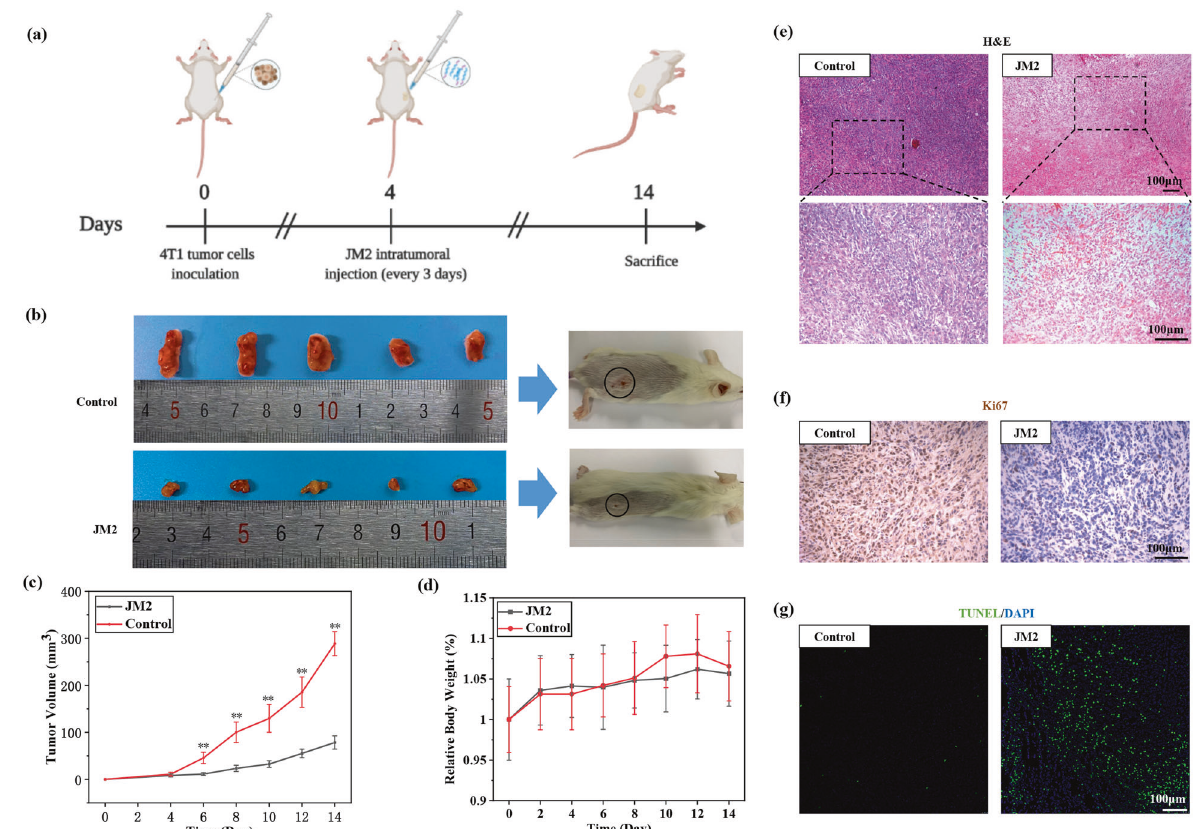
Fig. 1 JM2 inhibited tumor growth in vivo. a Schematic illustration of the in vivo anti-tumor experimental protocol. b Representative images of tumors in Control and JM2 groups at day 14. c Tumor volume at each time interval measured during treatment. d Body weight curve of mice monitored during treatment. e H&E staining of tumors obtained from Control and JM2 groups at day 14. f Ki67 immunohistochemical staining (brown) of tumors obtained from Control and JM2 groups at day 14. g TUNEL staining (green) and DAPI staining (blue) of tumors obtained from Control and JM2 groups at day